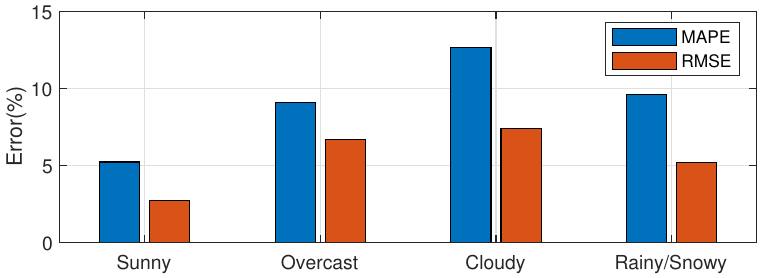
Figure 12. Performance of forecast results under four generalized weather types.